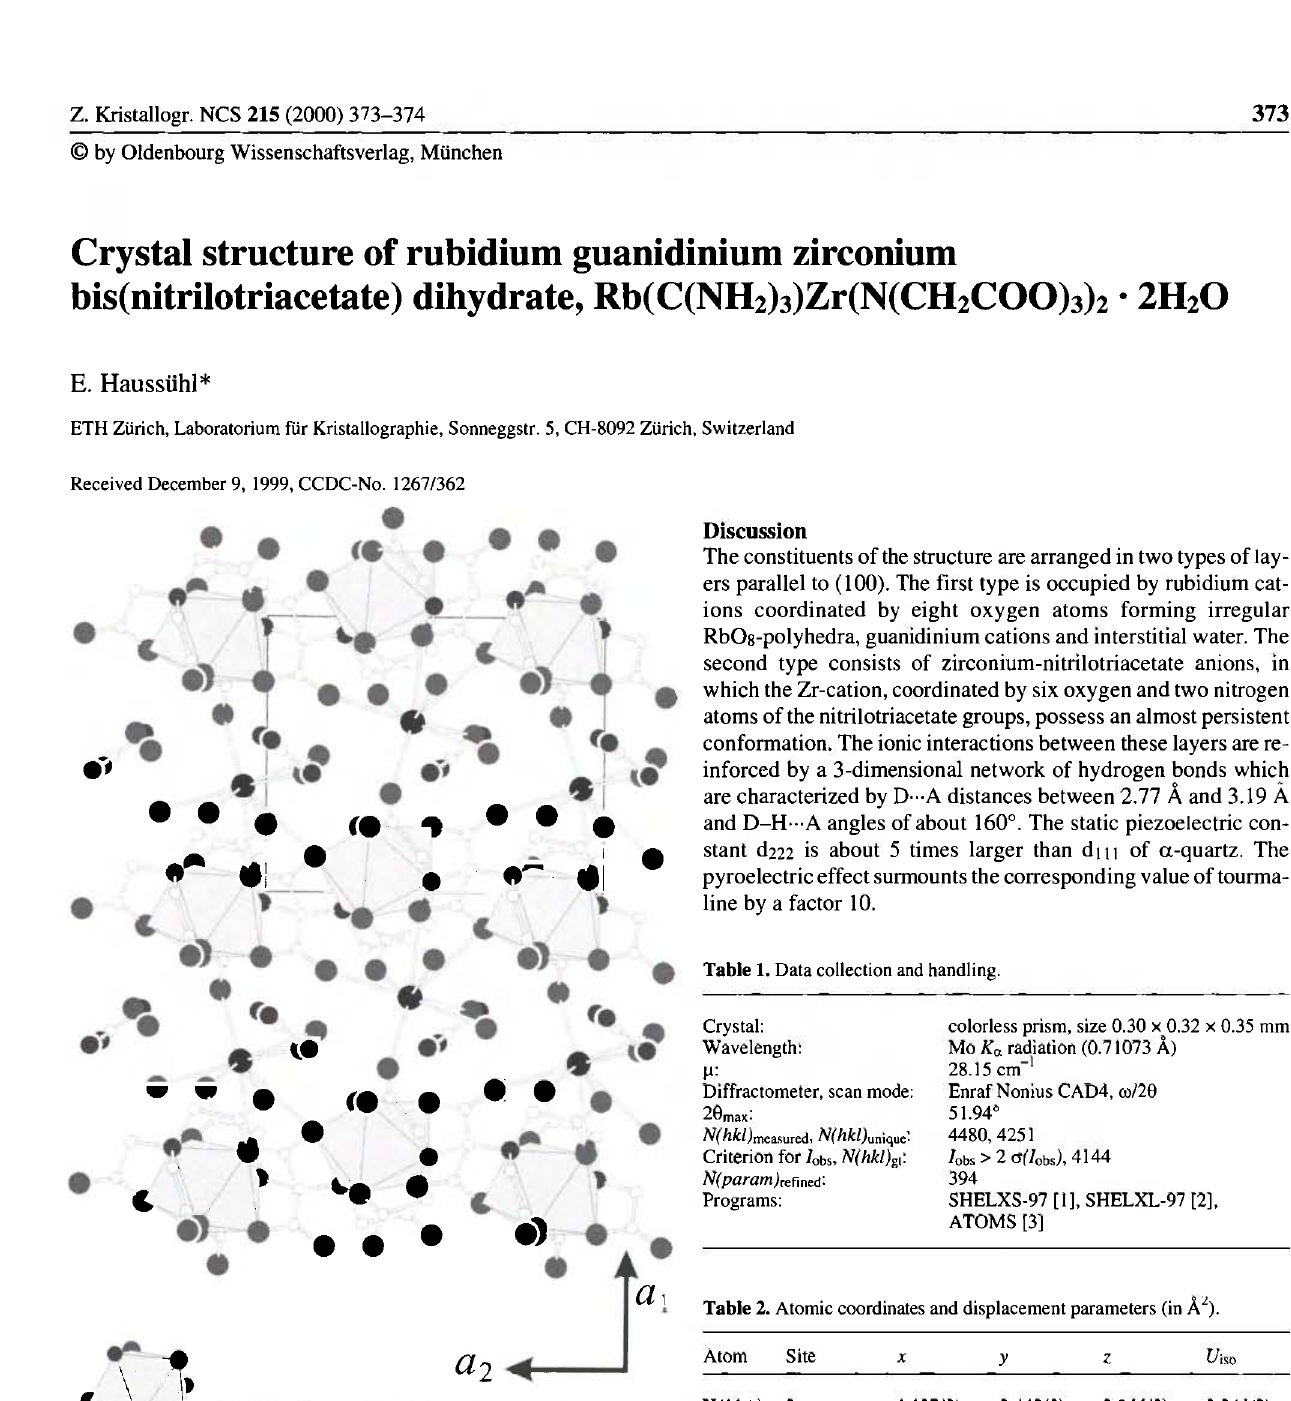
Table 2. Atomic coordinates and displacement parameters (in Ä